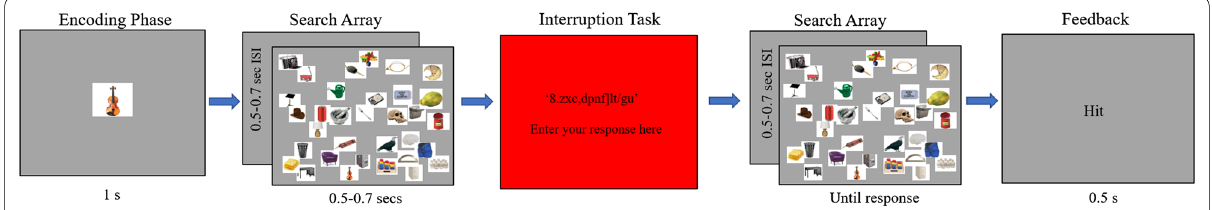
Fig. 2 Layout of an interrupted trial. In Experiment 1, participants searched for a new target on every trial. In Experiment 2, participants searched for the same target on each trial. Search arrays contained 150 distractors. Interruptions occurred 0.5–0.7 s from the onset of the search